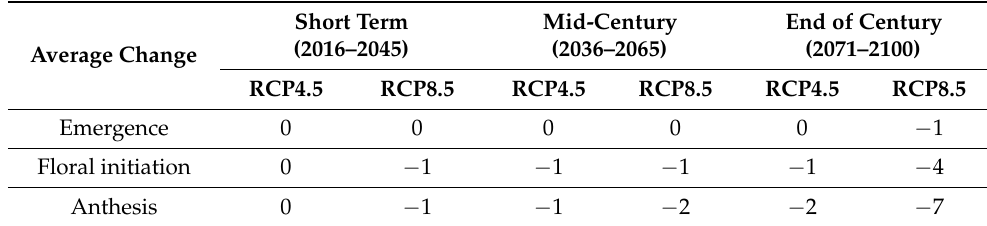
Table 3. Average number of days to change in phenology of wheat, averaged from four GCMs relative to the reference period of